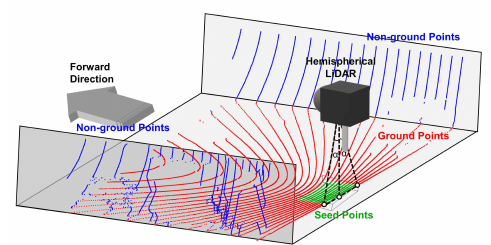
Figure 4. Ground segmentation for a forward-mounted hemispherical view